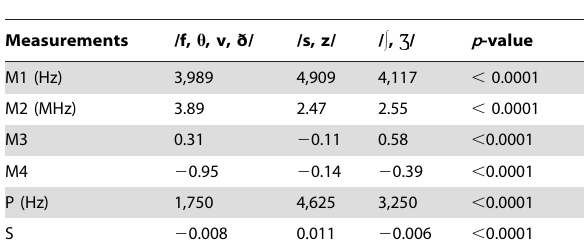
Table 1. Median values and Kruskal-Wallis test results ( p -values) for six acoustic features for the training set.